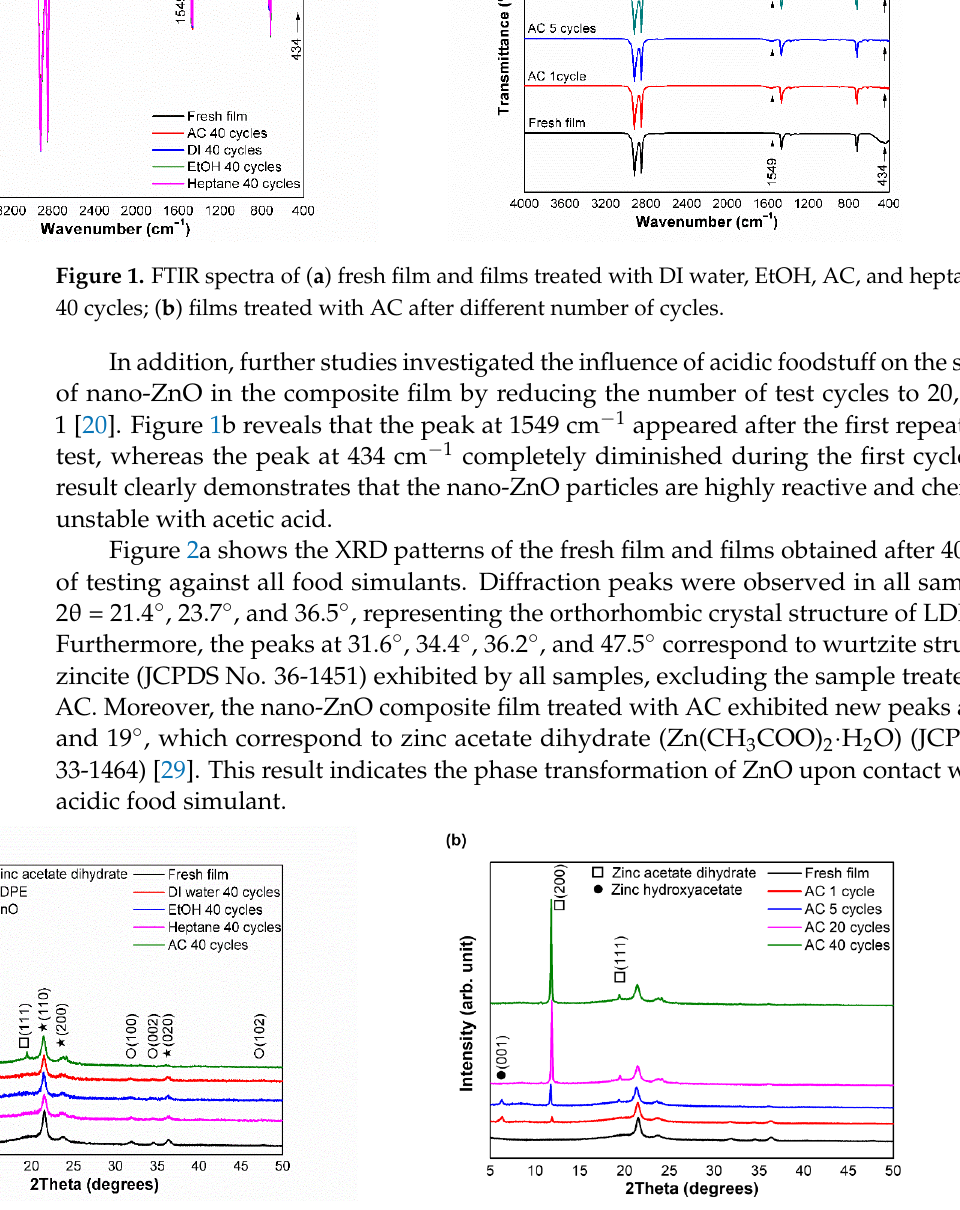
Figure 2. XRD patterns of ( a ) fresh film and films treated with DI water, EtOH, AC, and heptane after 40 cycles; ( b ) XRD patterns of films treated with AC after different number of